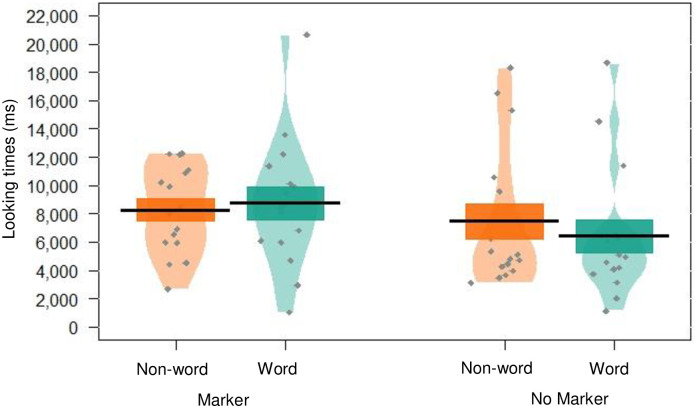
Pirate plot depicting the (raw) mean looking times to words and non-words, given for each condition.Black lines indicate the mean, and coloured blocks indicate SE. The distribution of looking times is illustrated for each group, with individual data points in grey.